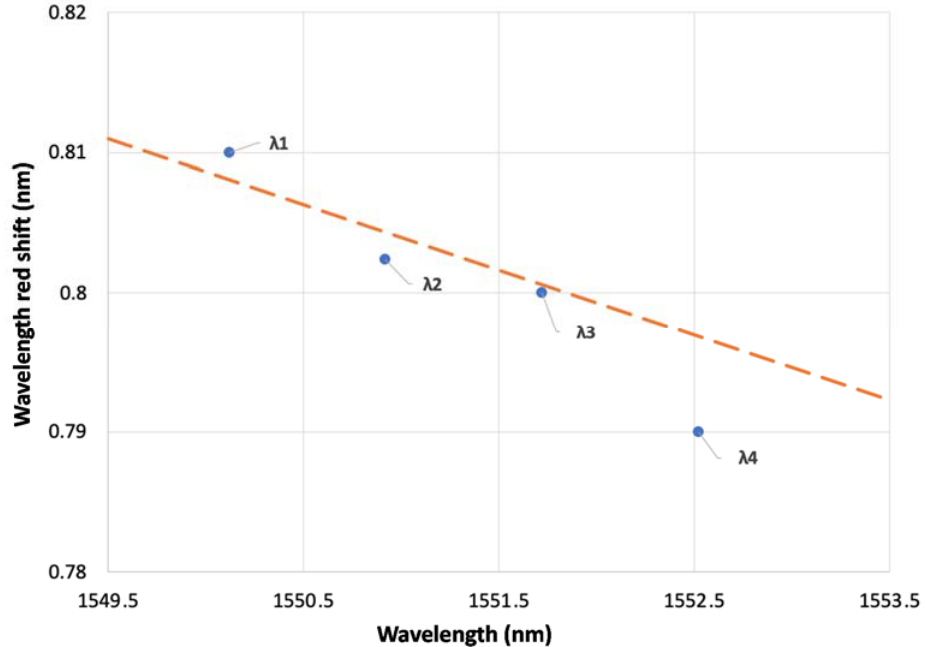
Figure 6. Wavelength red shift for the SOA biased at 250 mA. The dashed line is simulations and the dots are measured values for λ 1 = 1550.12 nm, λ 2 = 1550.92 nm, λ 3 = 1551.72 nm, and λ 4 = 1552.52 nm.